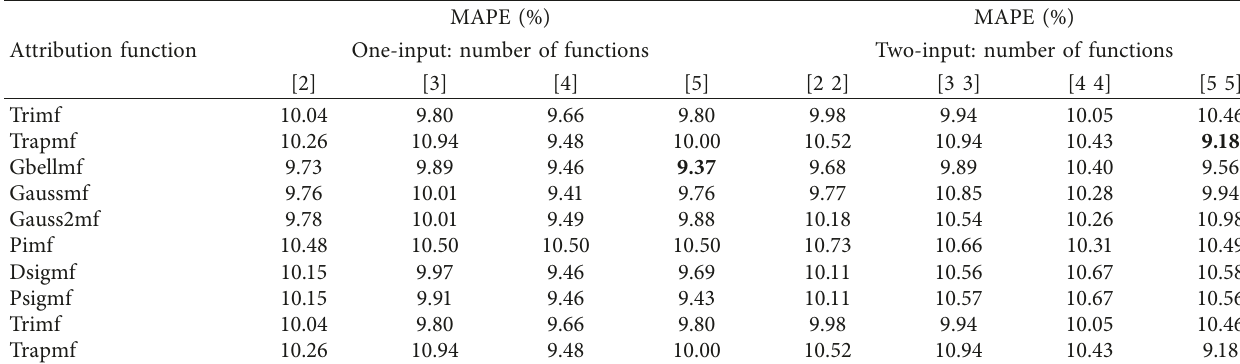
Table 4: Adaptive neuro-fuzzy inference system (ANFIS)